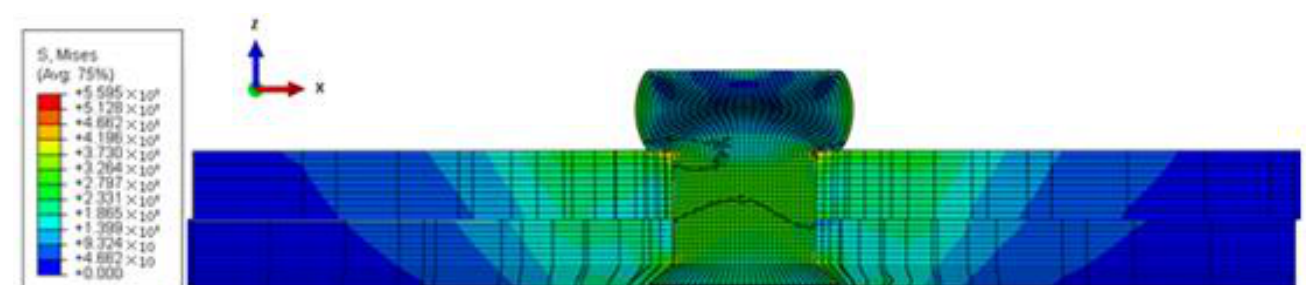
Figure 4. Mises stress distribution of riveted parts (unit: MPa) (global). The stress distribution of the rivet and the hole area is shown in Figure 5 and their stress map is consistent. It can be seen from the figure that the residual stress changes not only in the radial direction, but also in the axial direction. The stress concentration is mainly in the contact area between the rivet and the edge of the hole. Compared with the rivet head, the stress concentration on the side of the driven head is greater, up to 595.5 MPa, which exceeds the yield limit of the rivet material. The reason for this result is that the elastoplastic deformation on the side of the driven head is the most severe, and the force is the most complicated. When the rivet is upsetting and deformed, the amount of interference on the side of the driven head and the connecting hole is greater.